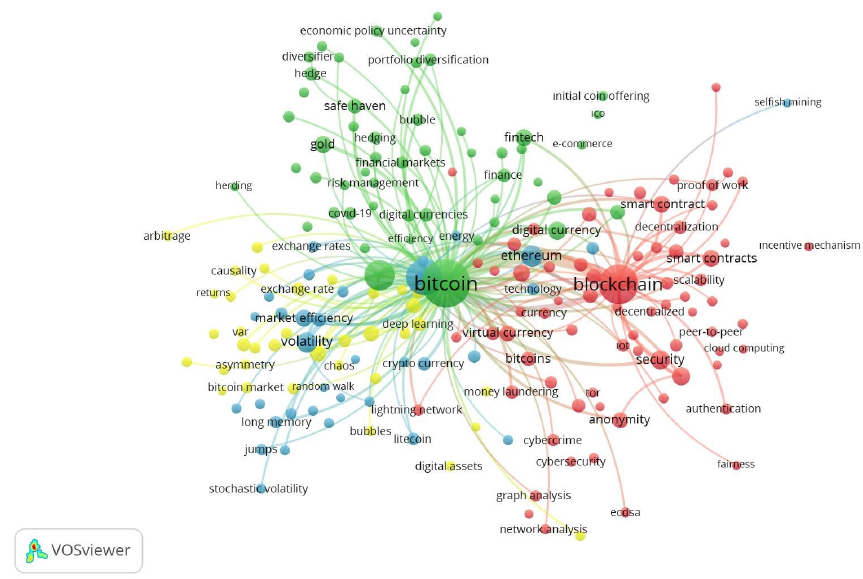
Figure 5. Keyword analysis of articles.